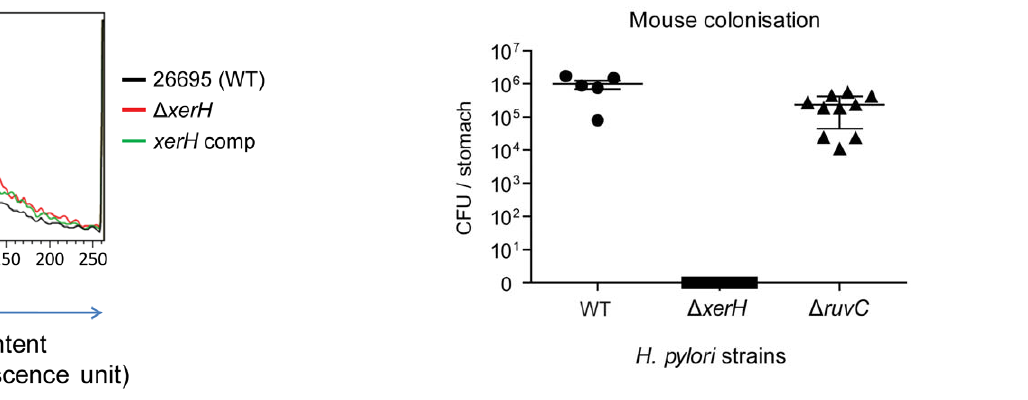
Figure 7. Impaired chromosome segregation in D xerH mutant. The X and Y axes indicate the relative Hoechst fluorescence units and number of H. pylori cells, respectively. Dotted vertical lines indicate genome equivalents. The main fluorescent signal of wild-type H. pylori was considered as one genome equivalent, as described [39].